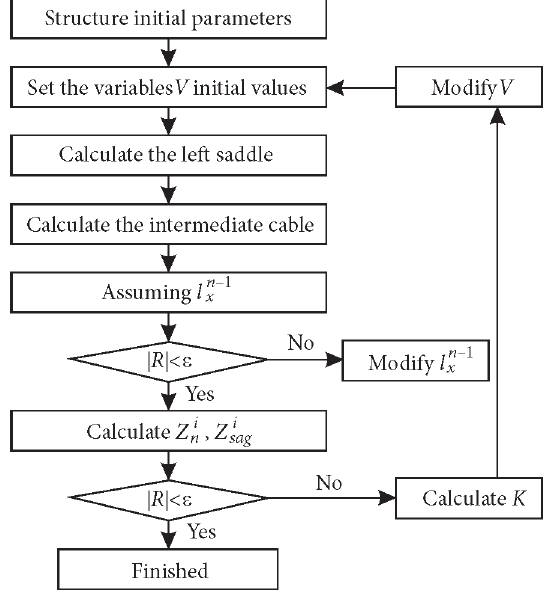
Fig. 4. Flow chart describing the iterative procedure